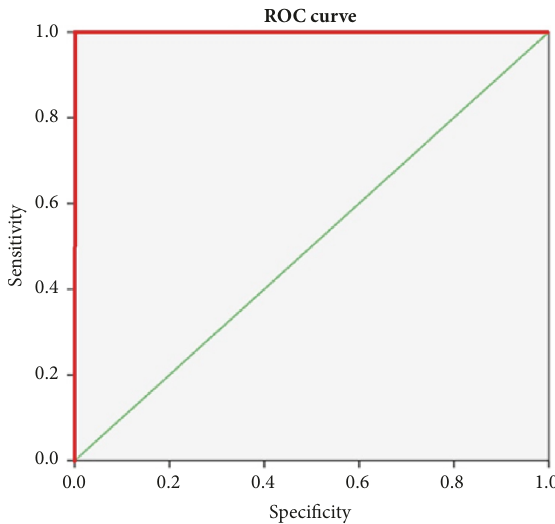
Figure 1: ROC curvefor Pro-ADM1 in predicting sepsis in the study